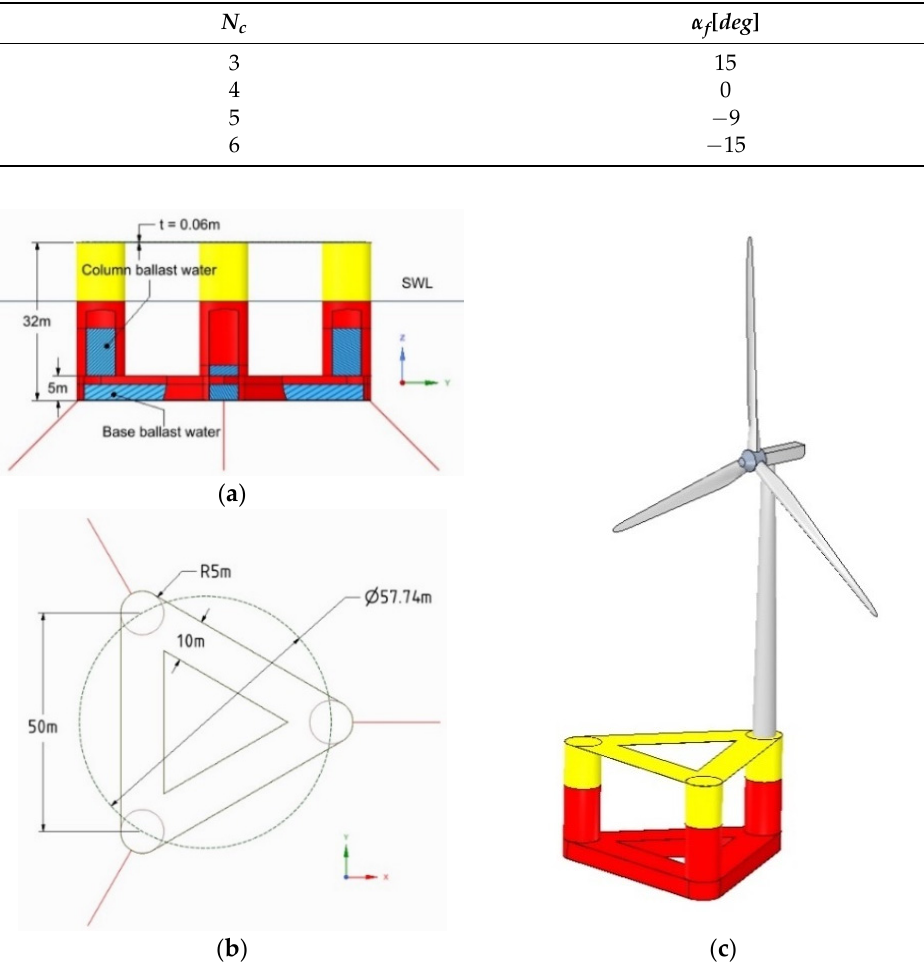
Table 5. Number of column factor along with 𝜶 𝒇 .